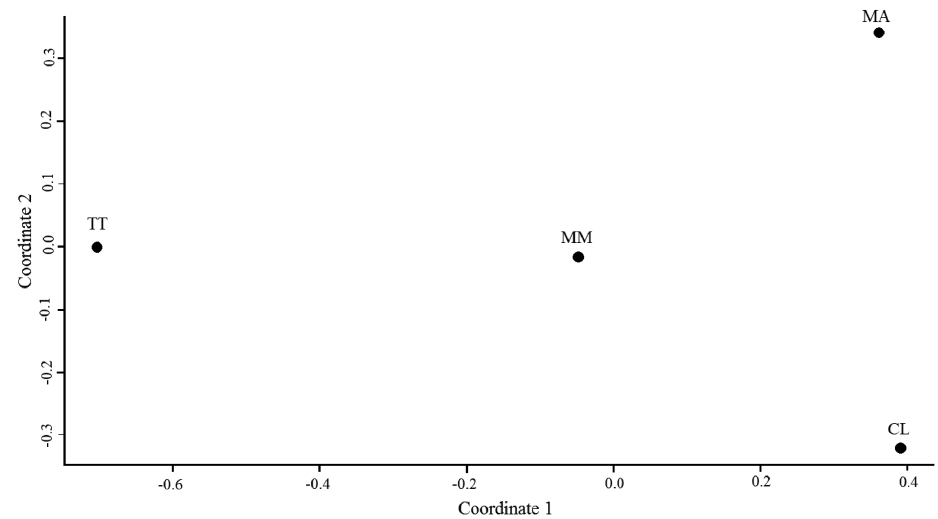
Figure 3 - Non-metric multidimen sional scaling analysis showing statistical placing of each species, considering all three niche axis (temporal, space and trophic). TT = Tropidurus torquatus ; CL = Cnemidophorus litorallis ; MA = Mabuya agilis ; MM = Mabuya macrorhyncha. Final con fi guration stress = 0.001; RSQ =